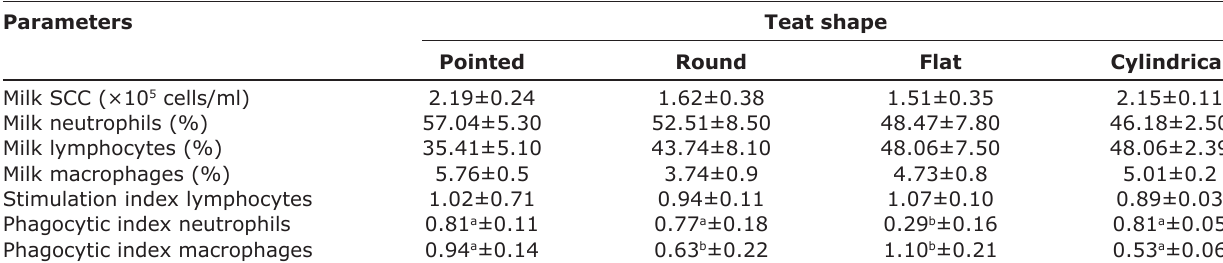
Table-2: Effect of teat shape on milk SCC, milk DLC and in vitro activity of milk leukocytes in high yielding crossbred cows. Parameters